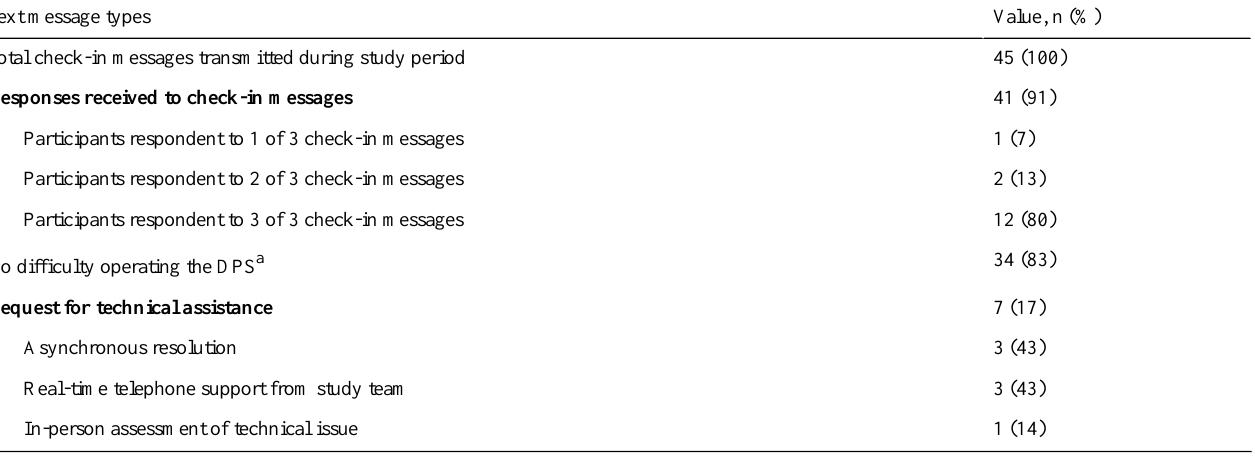
Table 2. Characteristics of messaging and follow-up during the digital pill system training